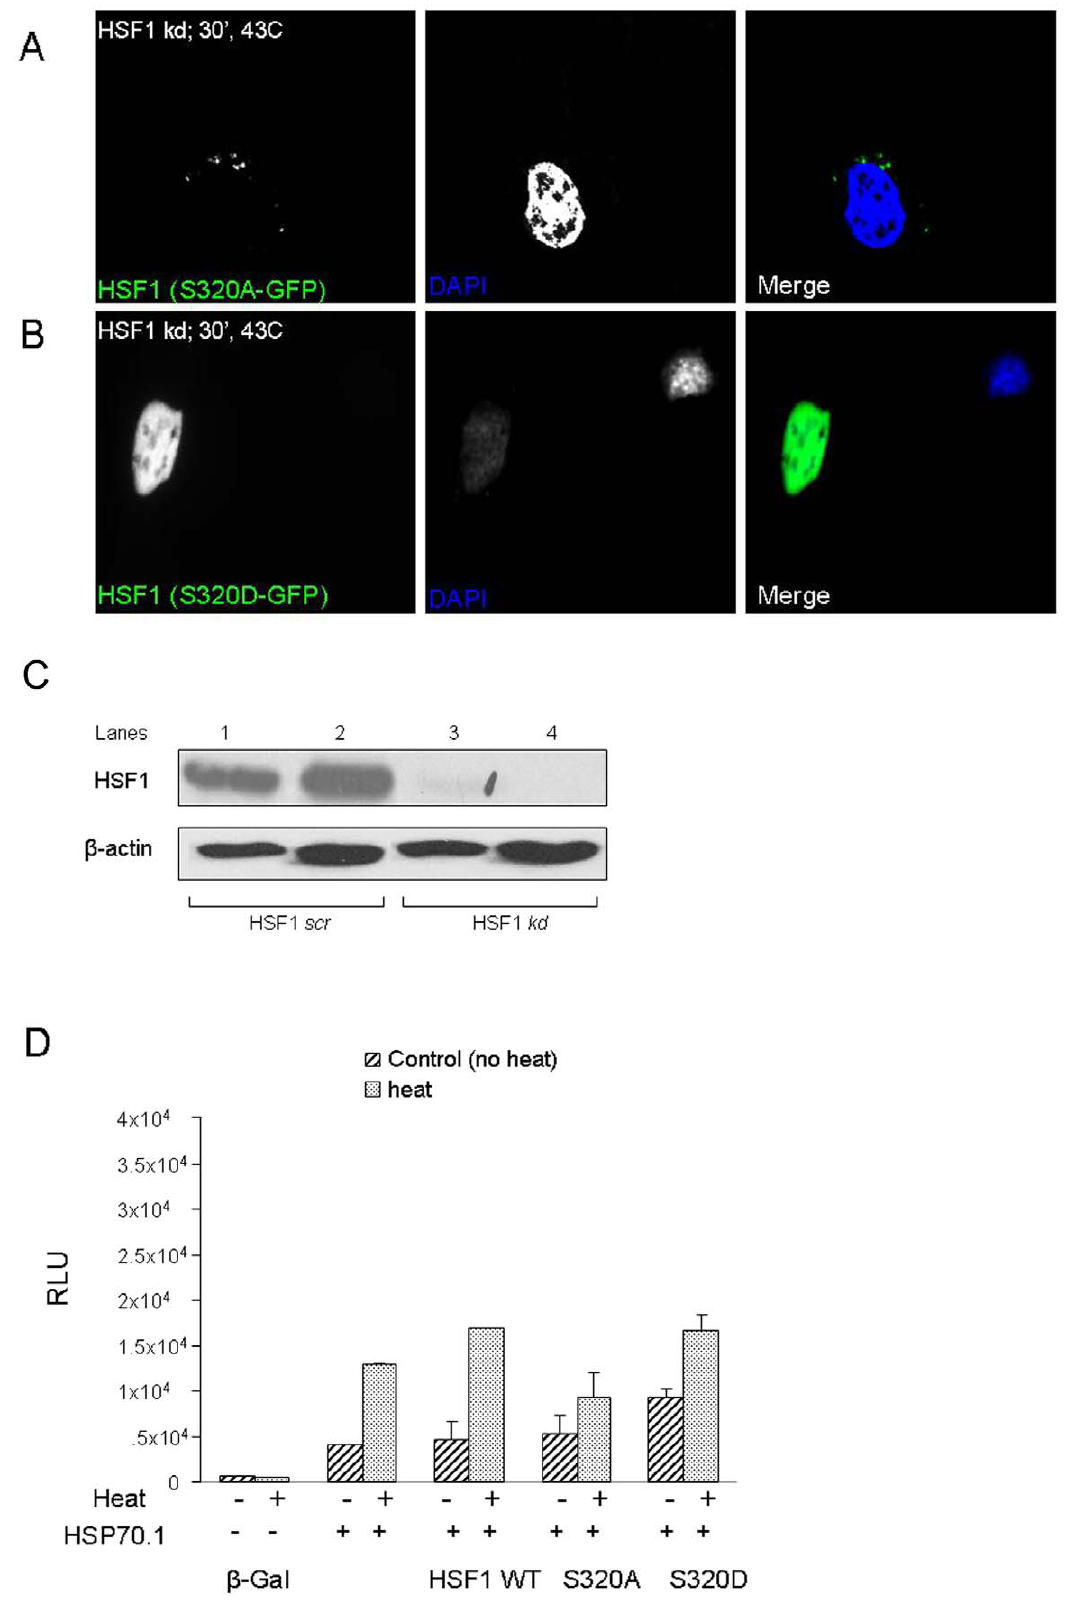
Figure 4. Phosphorylation at S320 influences the intracellular localization and activity of HSF1. A, B ) Du145 cells with stable HSF1 knockdown were transiently transfected with either HSF1 (S320A)-GFP or HSF1 (S320D)-GFP and later heated at 43 u C for 1 hour. Nuclei were detected using DAPI staining. C ) Lysates from the HSF1 kd cells and control cells expressing scrambled RNA ( scr ) were analyzed in duplicate for HSF1 with anti-